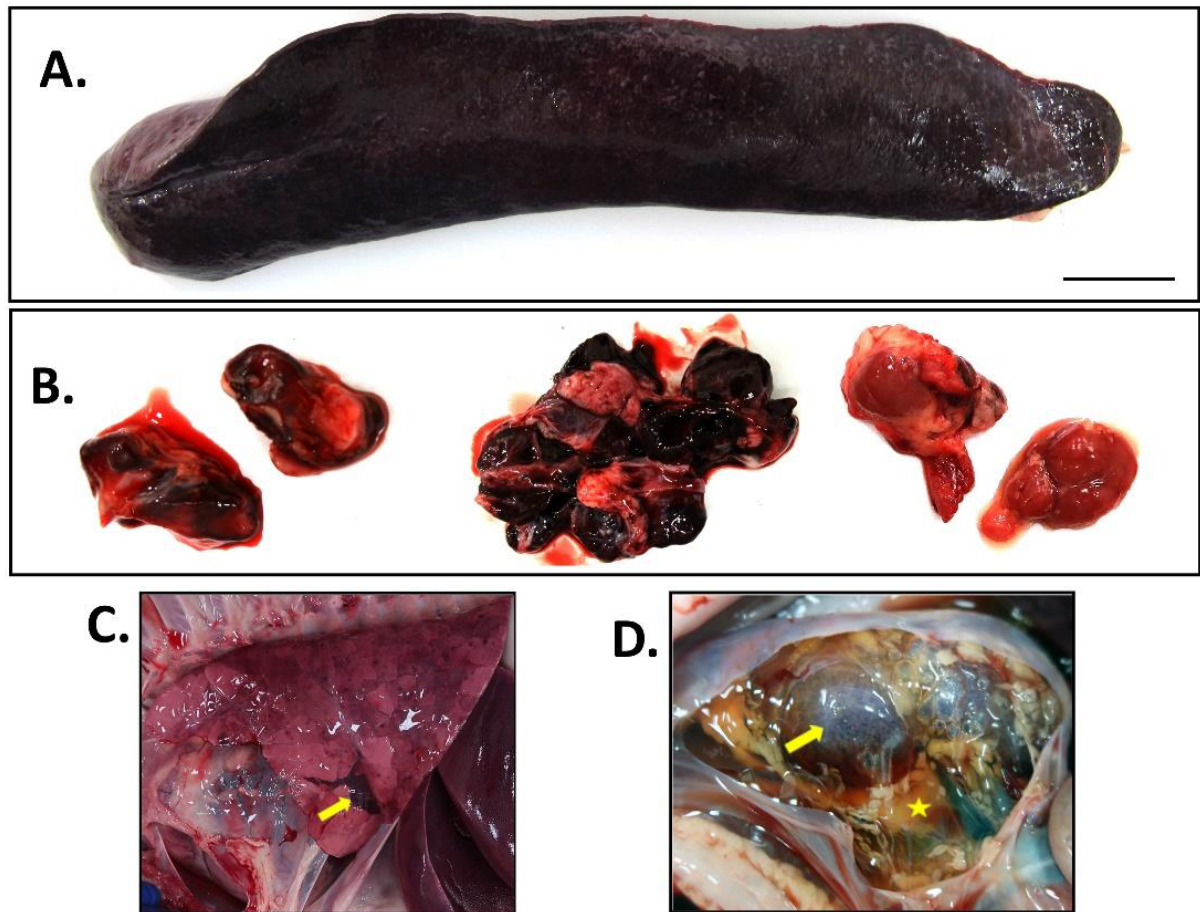
Figure 6. Gross pathology lesions following ASFV-MNG19 infection. ( A ) Spleen: severe splenomegaly; ( B ) Lymph nodes: hemorrhage (from left to right: renal lymph node, gastrohepatic lymph node, and cranial mediastinal lymph node); ( C ) Lungs: pulmonary edema with congestion, consolidation (yellow arrow), and ecchymosis; ( D ) Kidney: retroperitoneal serous effusion indicated by the yellow star, petechial hemorrhages of renal cortex indicated by the yellow arrow.